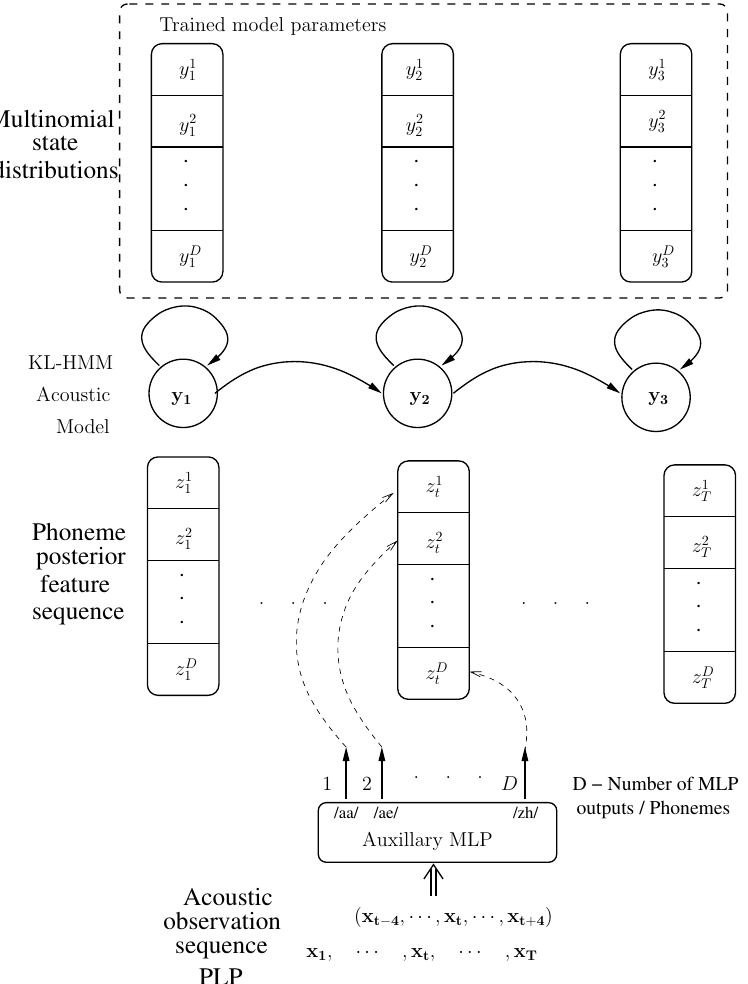
Figure A1. Illustration of KL-HMM